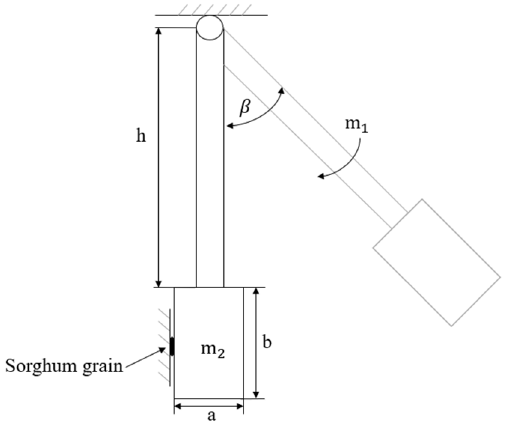
Figure 5. Schematic diagram of sorghum seed impact. Where m 1 is the pendulum mass, kg; m 2 is the pendulum mass, kg; h is the pendulum length, m; a is the pendulum length, m; b is the pendulum height, m.